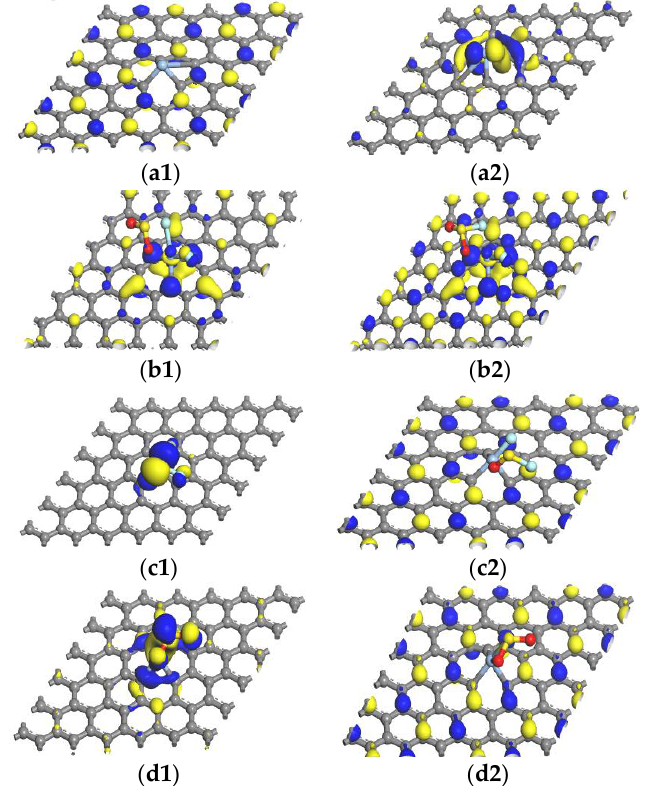
Figure 8. HOMO and LUMO: ( a1 , a2 ) Ag-graphene; ( b1 , b2 ) single SO 2 F 2 , ( c1 , c2 ) single SOF 2 ; ( d1 , d2 ) single SO 2 .